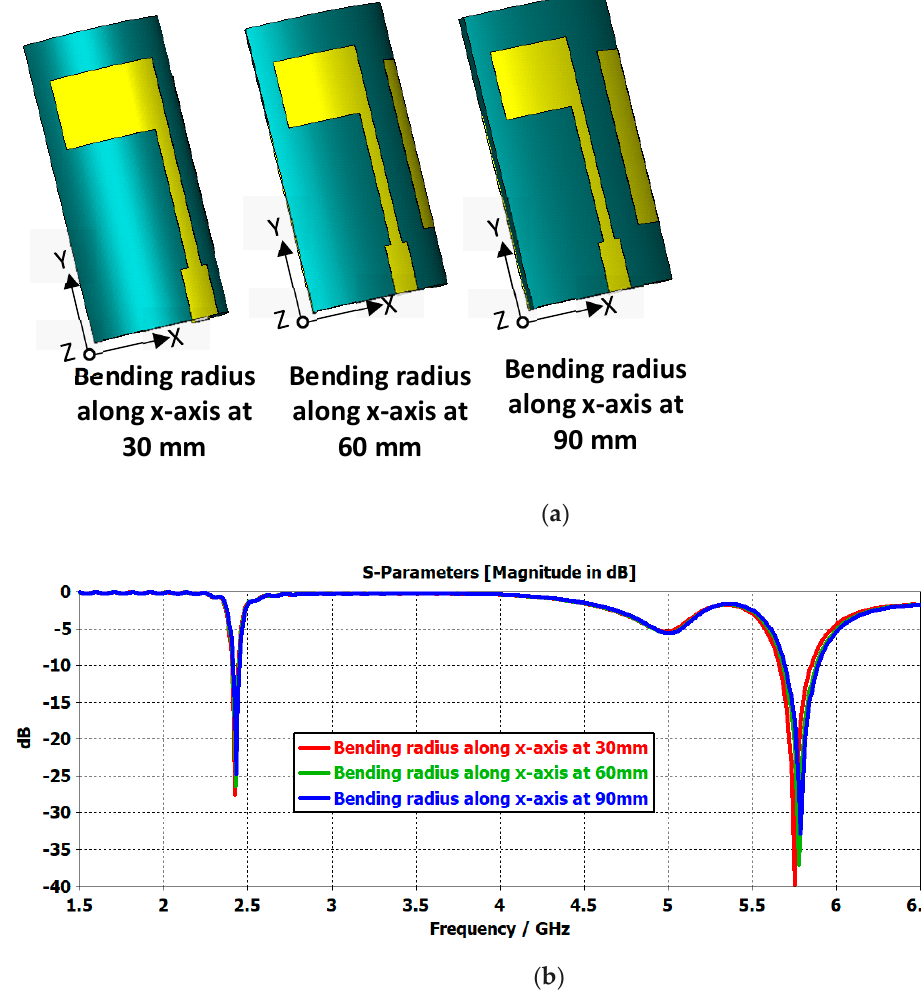
Figure 7. ( a ) Bending analysis of the antenna along the x -axis; ( b ) S 11 behavior at Bx = 30, 60 and 90 mm.